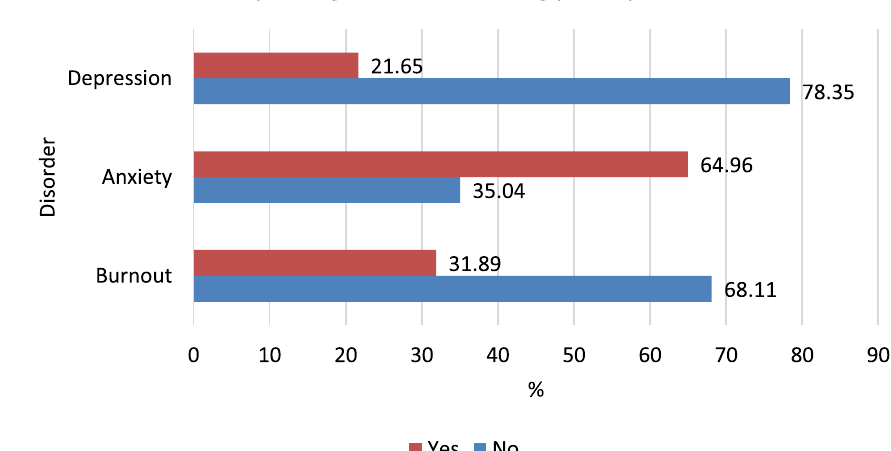
Fig. 1 Prevalence of depression, anxiety, and burnout among Egyptian house officers amid the COVID-19